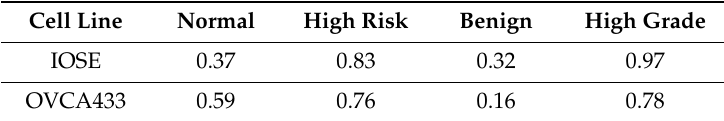
Table 1. Pearson correlation coefficients between cellular f-actin fibers and stromal collagen fiber distributions of IOSE and OVCA433 cells for the four models.